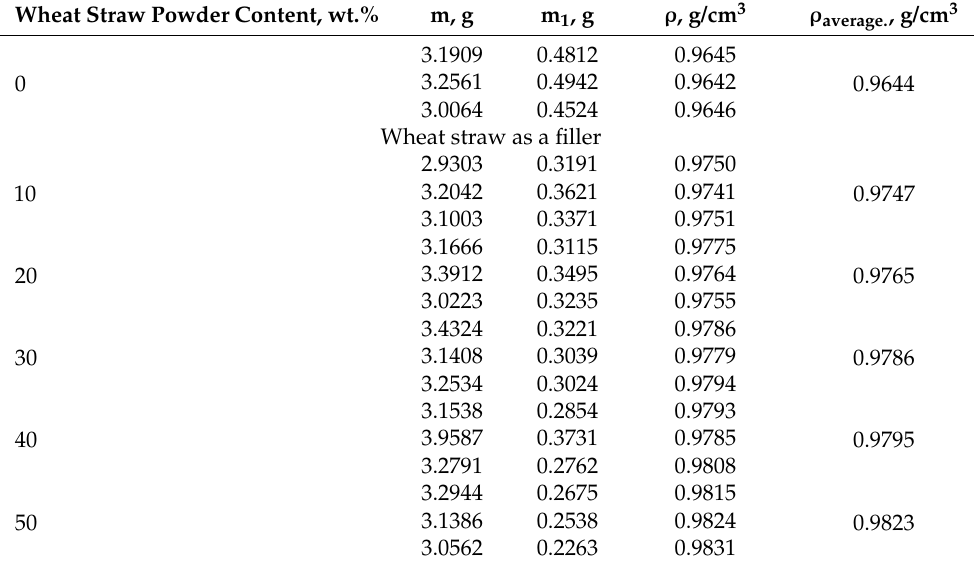
Table 1. Average density of composites with wheat straw. Wheat Straw Powder Content, wt.%